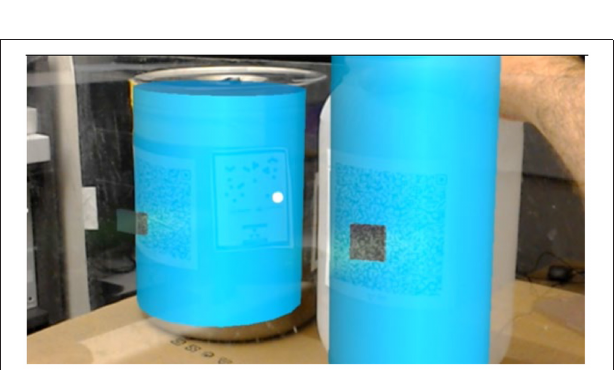
FIGURE 17 | The operator brings the canisters closer and farther from one another as they are working.